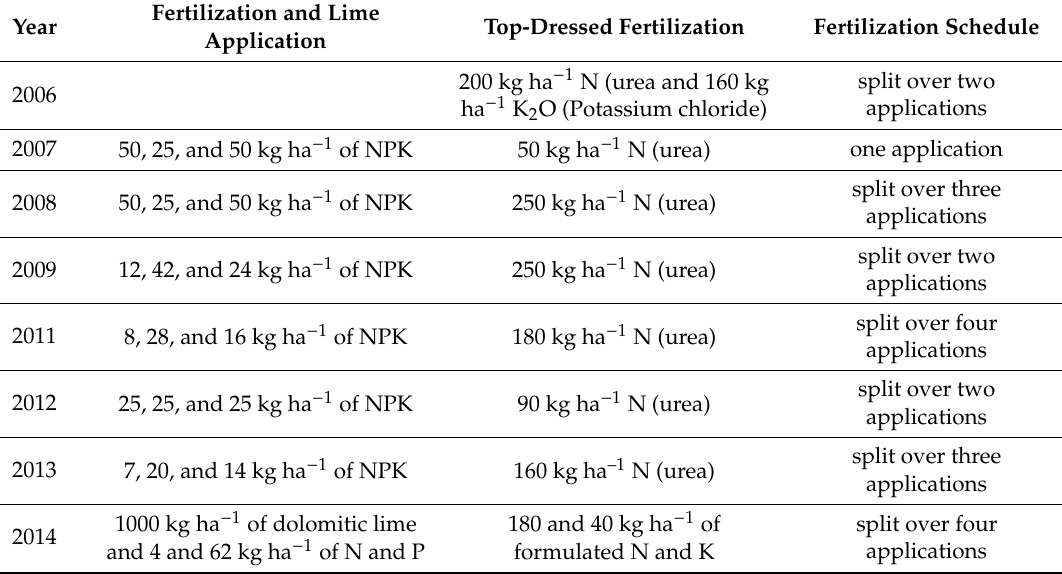
Table 2. Description of pasture fertilization during the experimental period. N: nitrogen; P: phosphorus; K: